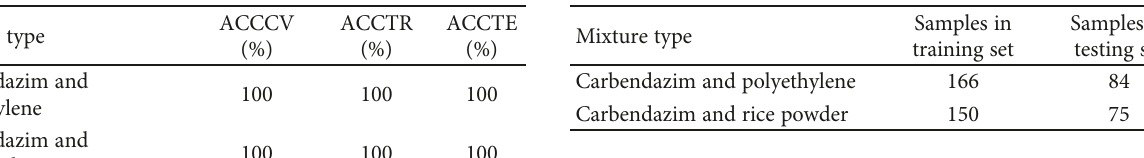
Figure 4: Grid search optimization parameter selection results of a 3D chart. (a) Carbendazim and polyethylene mixture. (b) Carbendazim and rice powder mixture. Table 1: Performance of qualitative analyses. Table 2: Samples in training set and testing